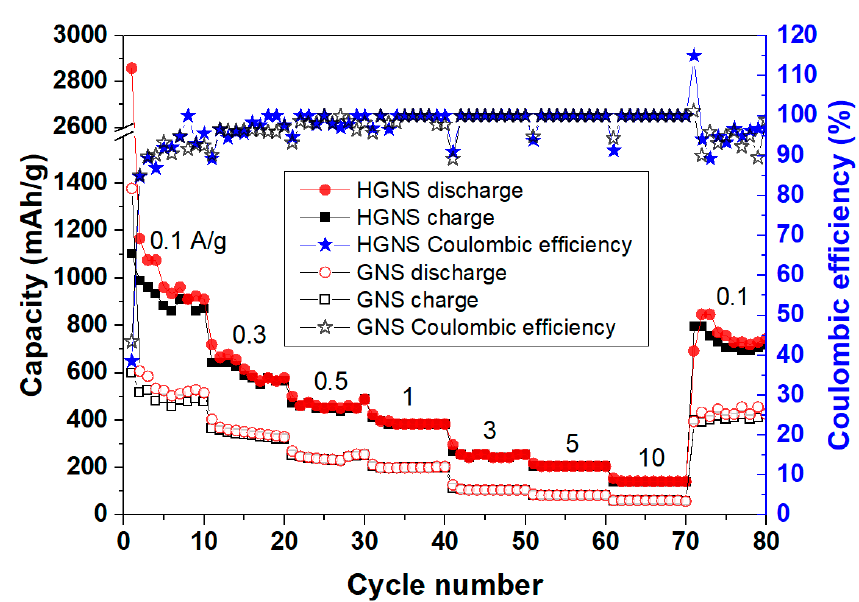
Figure 6. Rate capability, Coulombic efficiency, and cycle performance of GNS and HGNS at various current densities from 0.1 to 10 A/g. Table 4. Comparison of graphene anodes in lithium ion batteries.